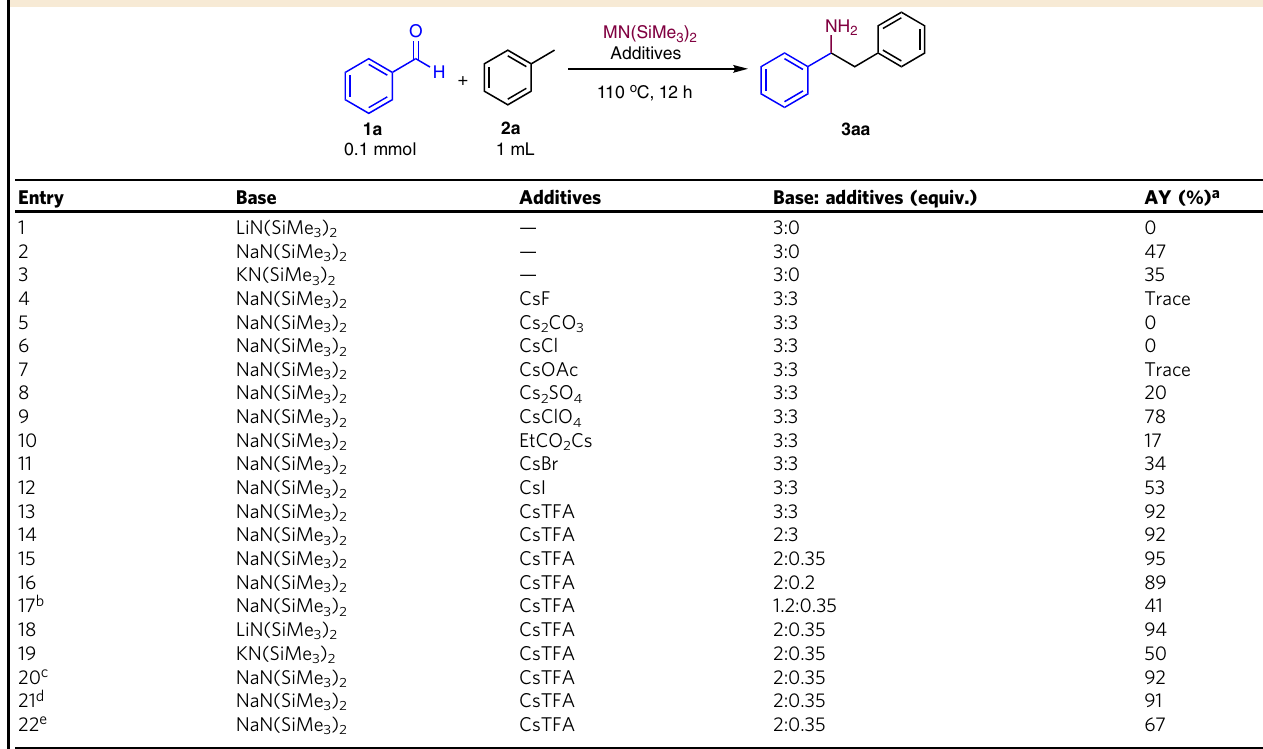
Table 1 Optimization of one-pot aminobenzylation of benzaldehyde +HO